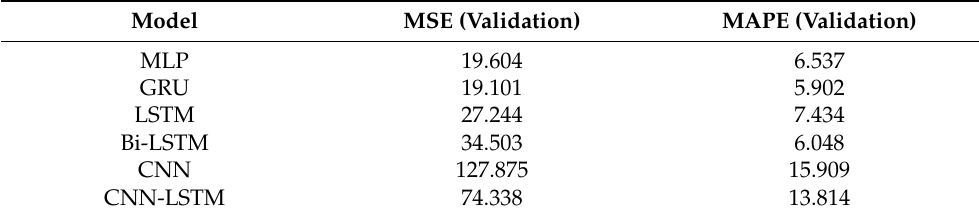
Table 16. The validation results of the models using ExxonMobil data with four input features.